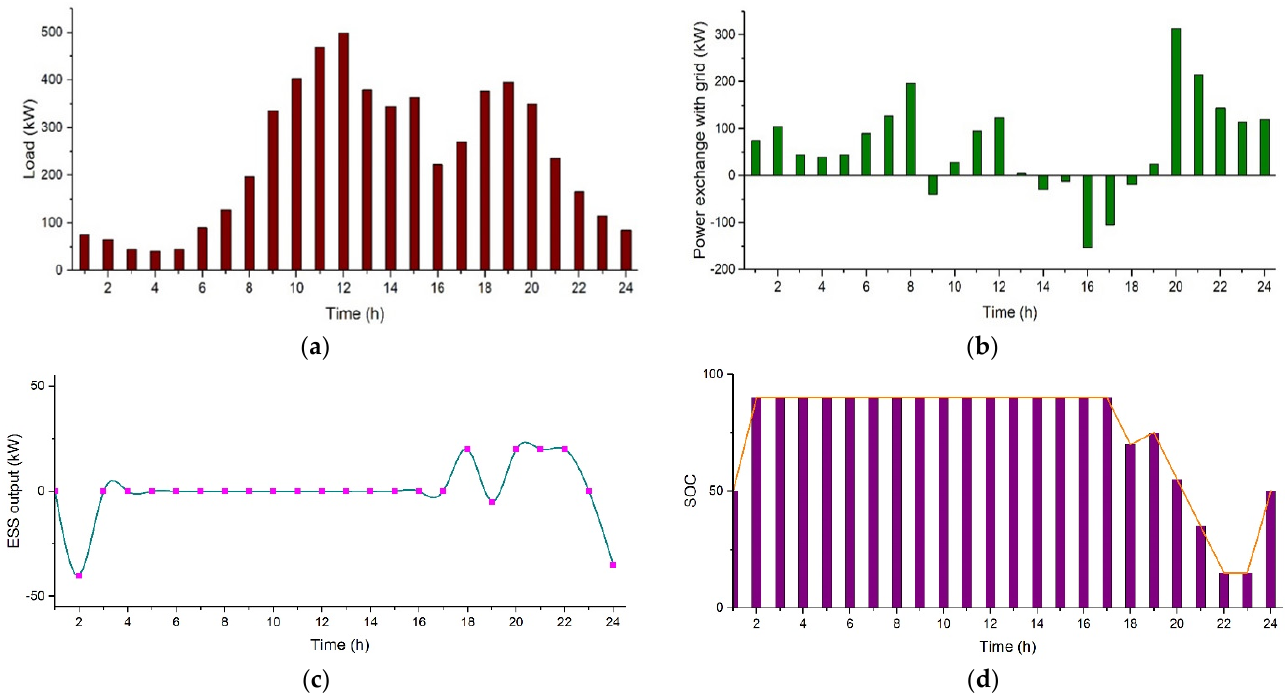
Figure 11. Case 4 (I), ( a ) College prosumer load profile with EVs integration, ( b ) Power exchange with the grid, ( c ) Power output of ESS , and ( d ) State of charge of